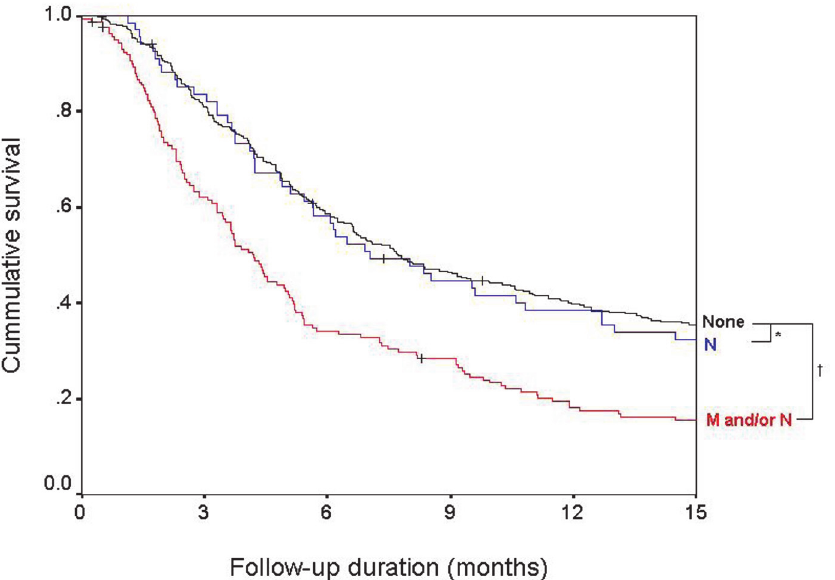
Fig 2. Survival of patients based on the type of extrahepatic spread. There was a significant survival difference based on the type of extrahepatic spread. Type of ES was classified as none (black), nodal metastasis only (N, blue) and distant metastasis with or without nodal metastasis (M and/or N, red). * P = 0.84; † P < 0.01.